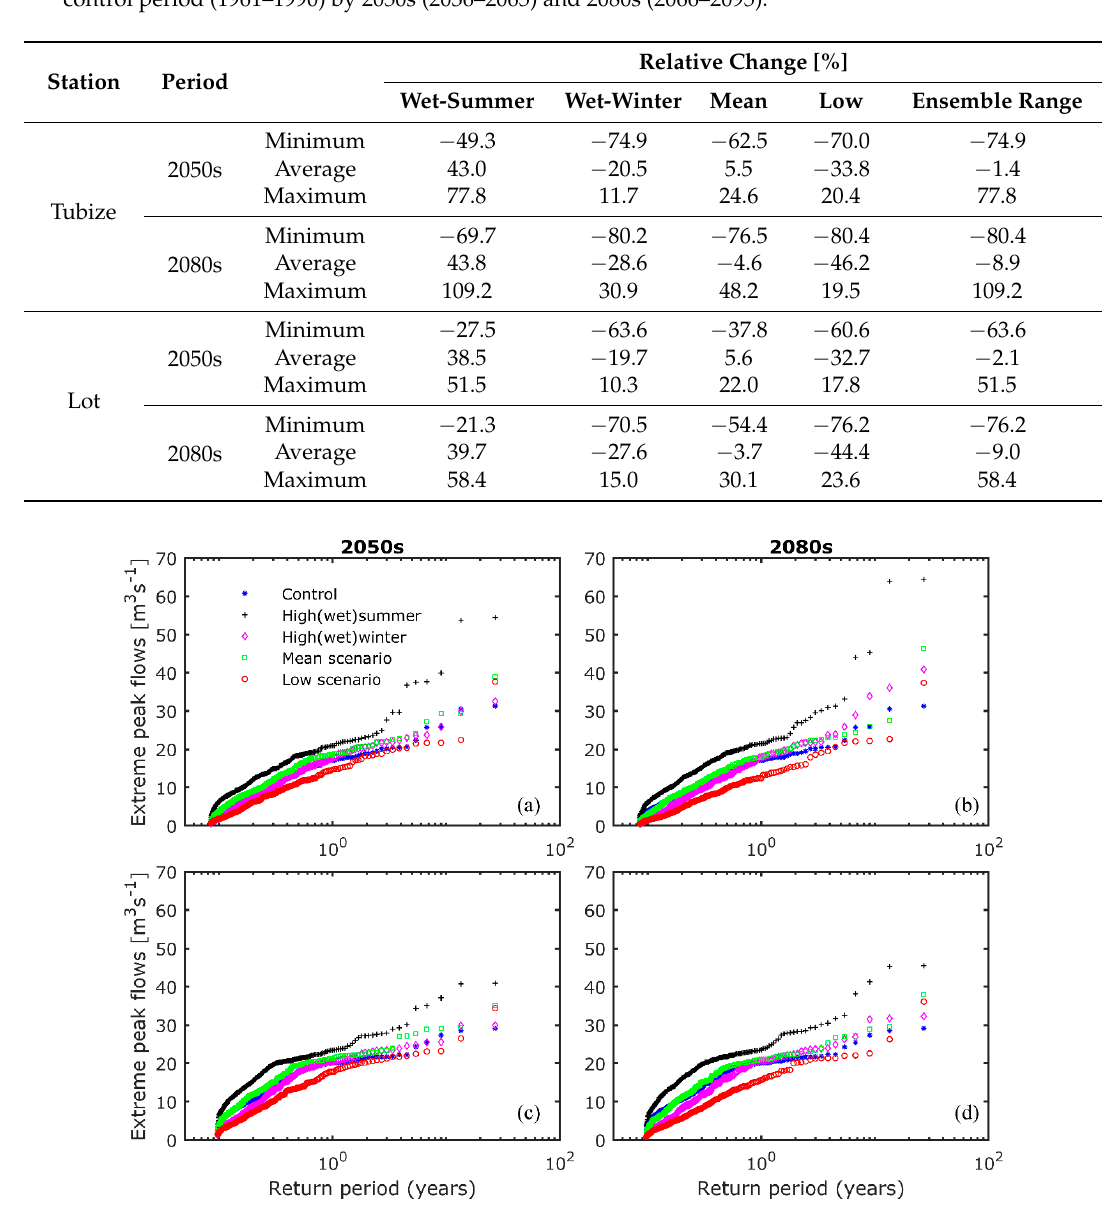
Table 2. Minimum, average, and maximum relative changes in extreme peak flows relative to the